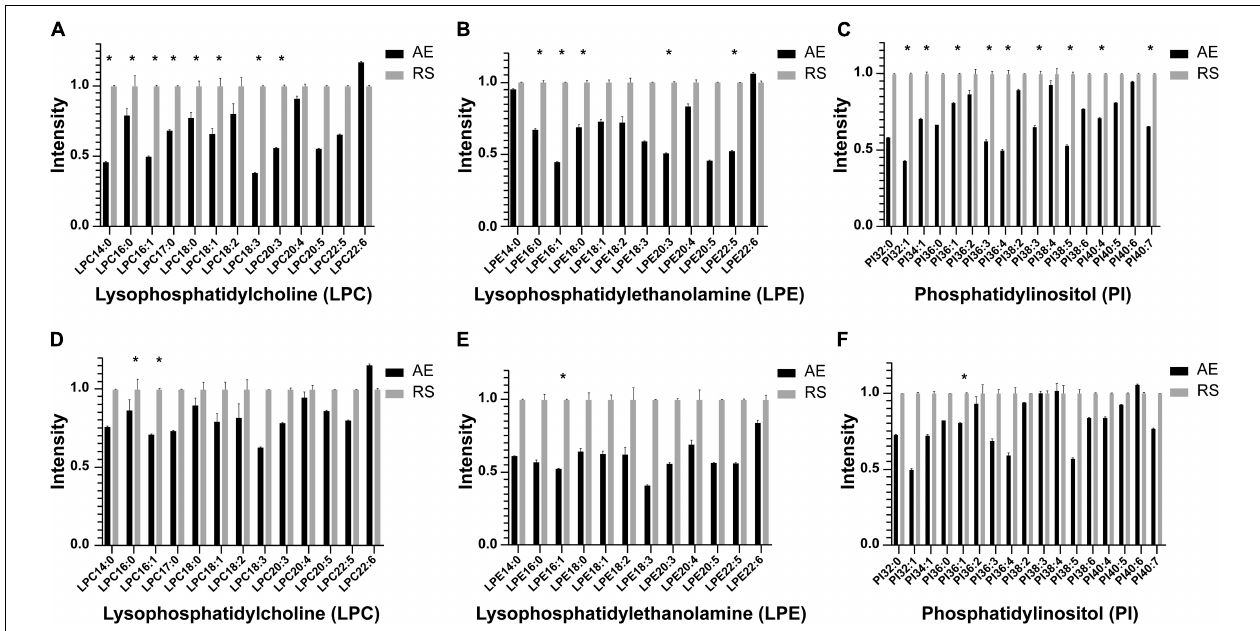
FIGURE 3 | Histogram showing LPC, LPE, and PI species in the metabolic profiles between the AE and recovery stages in different inflammatory subtypes. (A–C) In patients with EOS% < 2%, the concentrations of LPC 14:0, LPC 16:0, LPC 16:1, LPC 18:0, LPC 18:1, LPC 18:3, LPC 20:3, LPE 16:0, LPE 16:1, LPE 18:0, LPE 20:3, LPE 22:5, PI 32:1, PI 34:1, PI 36:1, PI 36:3, PI 36:4, PI 38:3, PI 38:5, PI 40:4, and PI 40:7 significantly decreased in the AE stage compared to the recovery stage (* P < 0.05). (D–F) In patients with EOS% > 2%, only the concentrations of LPC 14:0, LPC 16:1, LPE 16:1, and PI 36:1 were significantly decreased in the AE stage compared to the recovery stage (* P <